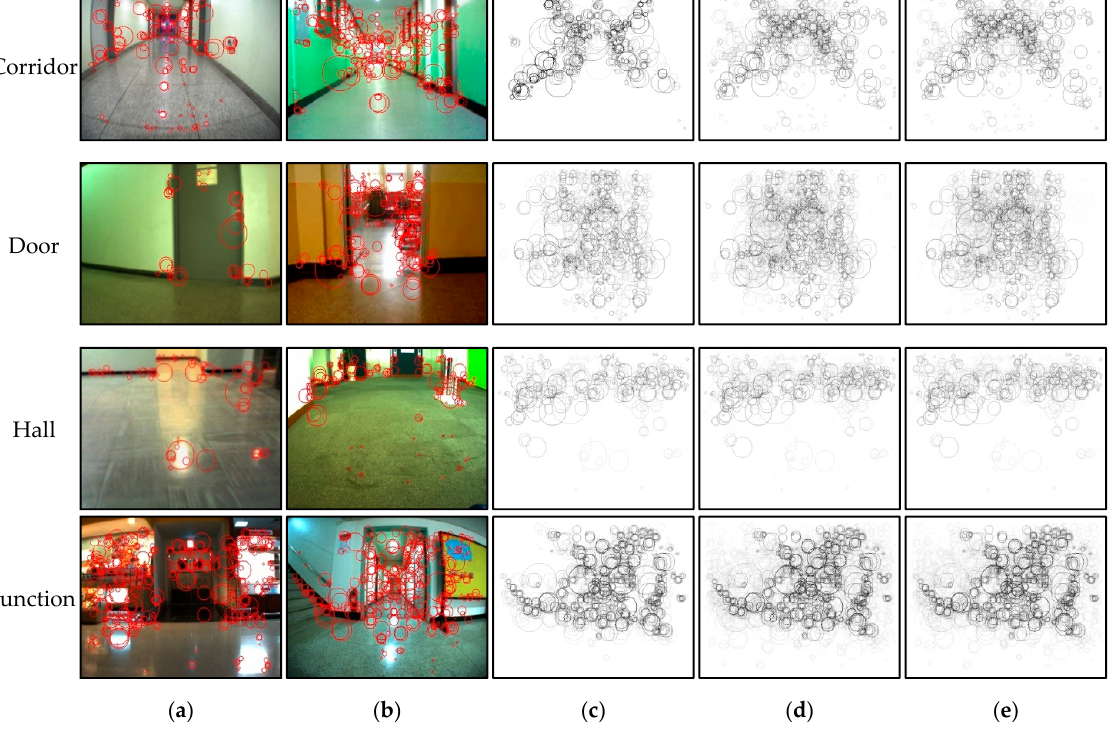
Figure 5. Characteristics of the SURF distributions among the situation types: ( a , b ) SURFs extracted from the ‘corridor’, ‘door’, ‘hall’ and ‘junction’ images; ( c – e ) SURF distribution accumulated with 5, 10, and 20 images, respectively.